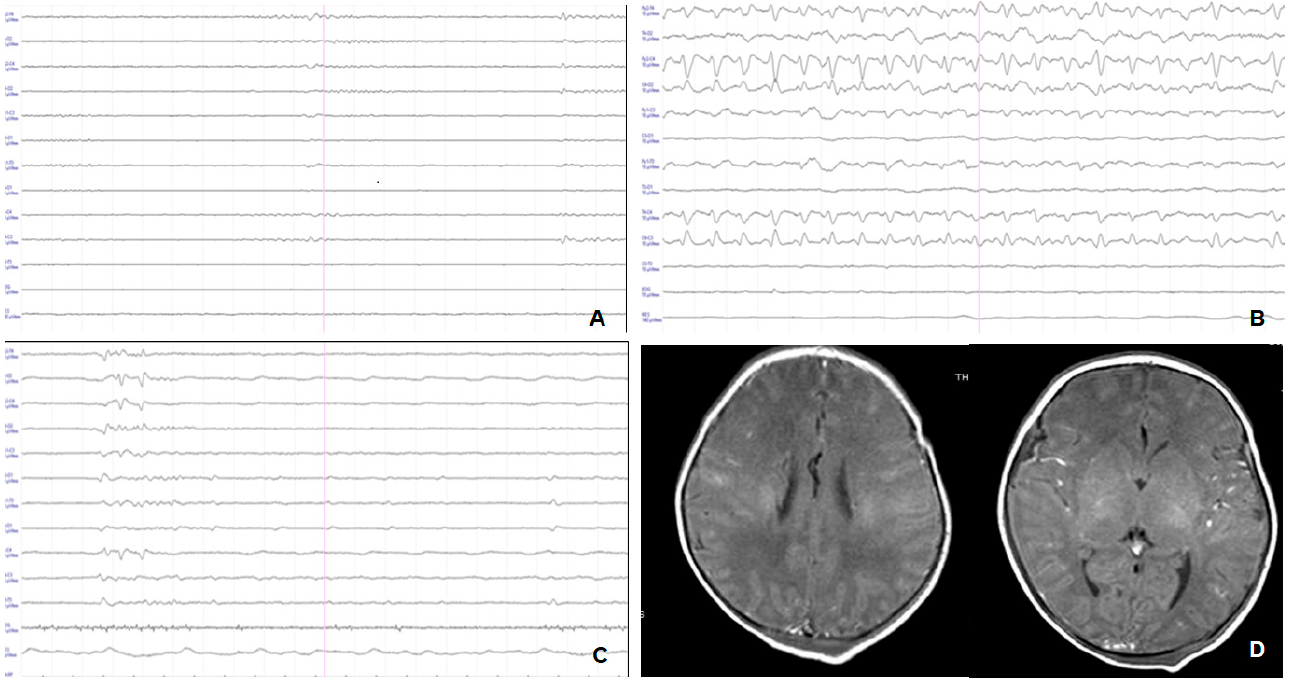
Figure 4. Patient 5 with severe HIE and severe neurodevelopmental outcome at 24 months of life. ( A ): p-EEG at enrollment (4 h of life) showing inactive EEG abnormalities (grade 4). ( B ): p-EEG at 12 h of life showing electrical seizures. ( C ): p-EEG at the end of TH showing severe EEG abnormalities (grade 3). ( D ): Cerebral MRI on day 5, showing pattern 1.